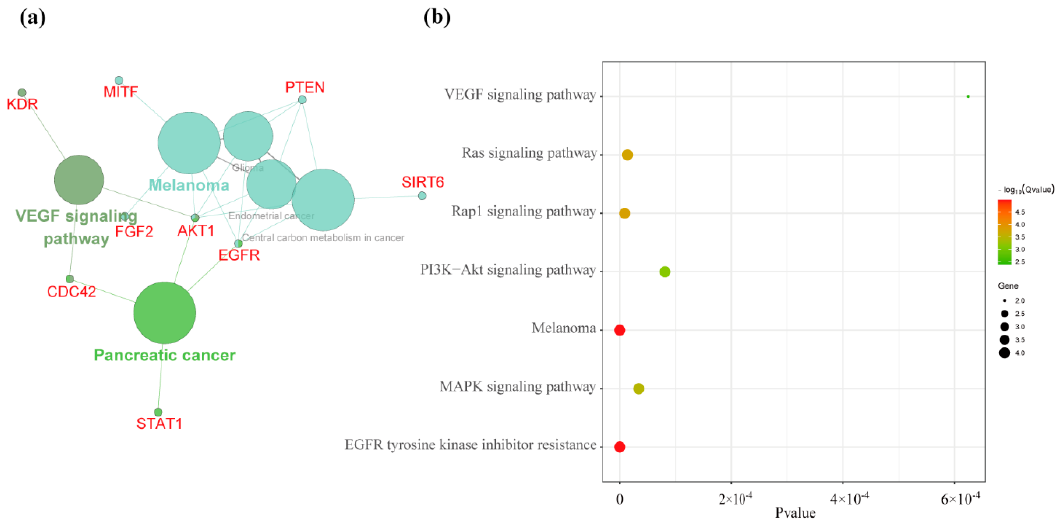
Figure 3. ( a ) Analysis of enrichment for the potential genes related to high-altitude adaptation by ClueGO; ( b ) Kyoto encyclopedia of genes and genomes (KEGG) analysis for the potential genes related to high-altitude adaptation by Kobas.